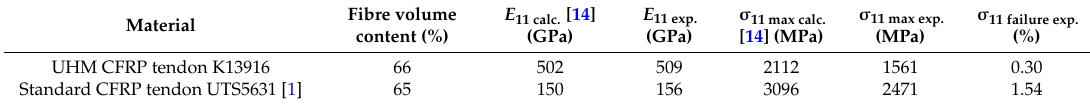
Table 1. Comparison of the tensile properties of UHM CFRP tendons versus standard CFRP tendons. Fibre volume E 11 calc. [14] Material content (%)